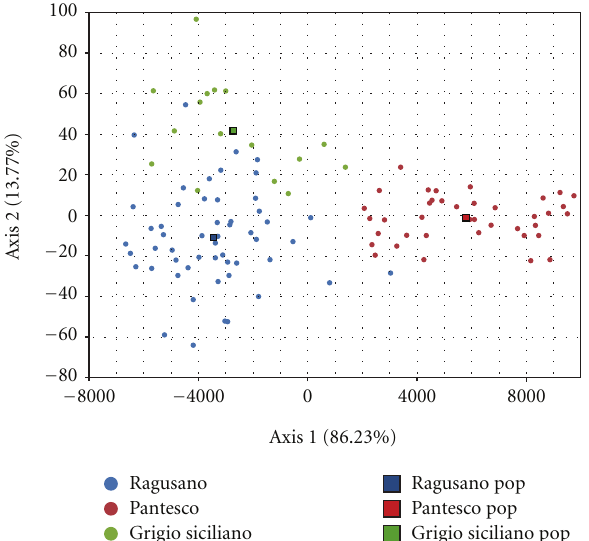
Figure 3: Plot of the correspondence analysis on allele frequencies of 13 loci of the three Sicilian donkey